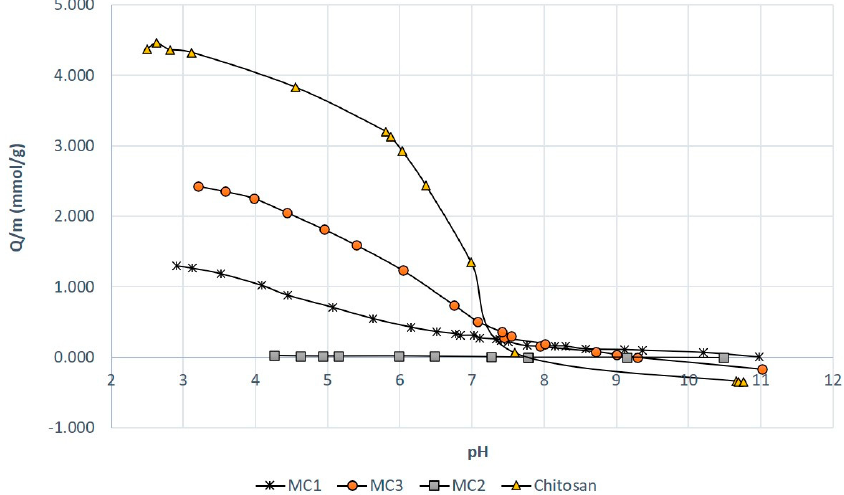
Figure 6. Potentiometric determination of amino groups in magnetic microparticles functionalized with chitosan using the microemulsion process (MC1), magnetic microparticles functionalized with chitosan using the suspension cross-linking process (MC2) and magnetic nanoparticles functionalized with chitosan using the covalent binding method (MC3).